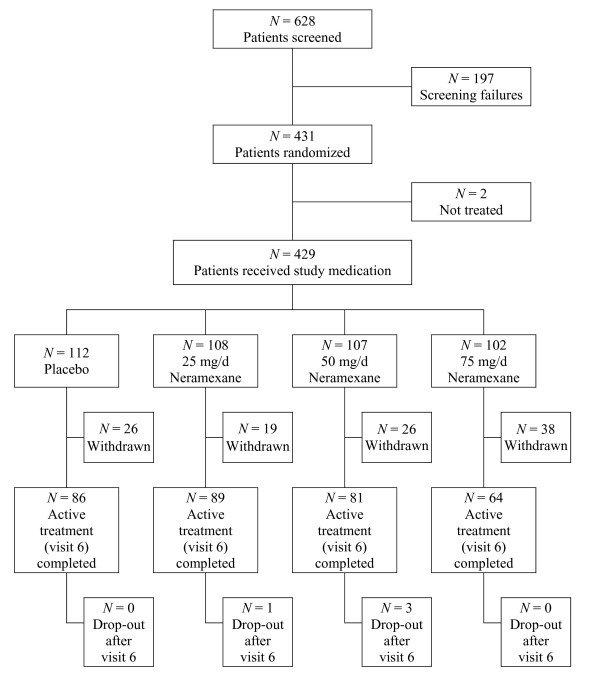
Patient disposition, flow chart